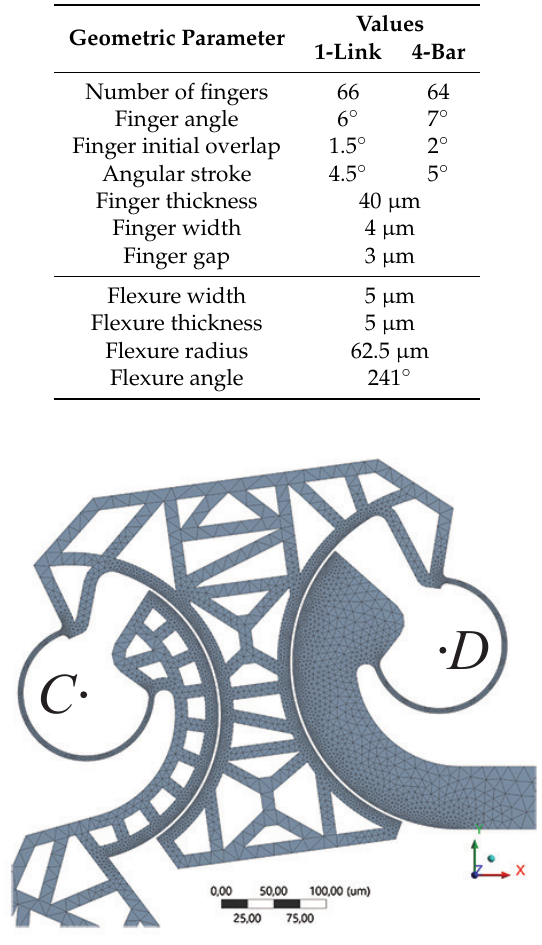
Figure 6. Detail of the refined mesh in two flexures, corresponding to the four-bars microgripper. Letters C and D refer to the same letters and structures presented in Figure